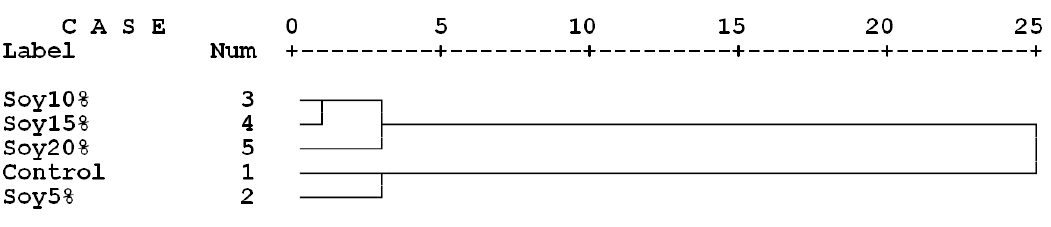
Figure 6. Cluster analysis of five different three-layer plywood panels produced with urea-formaldehyde resin, and 5%, 10%, 15%, and 20% soy flour substitution for UF resin (Soy% = soy flour content).